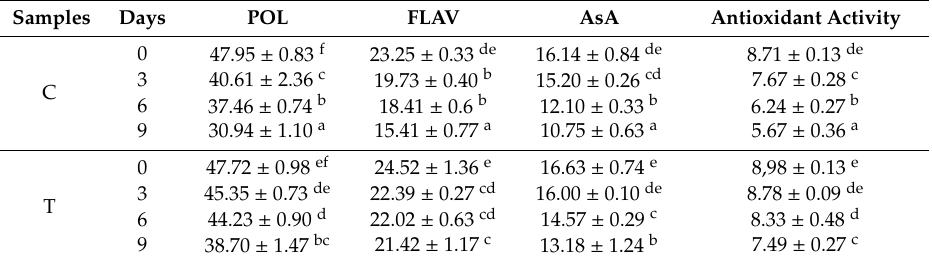
Table 2. Polyphenol (POL; mg GAE / 100 g FW), flavonoid (FLAV; mg CE / 100 g FW), ascorbic acid content (AsA; mg / 100 g FW) and antioxidant activity (DPPH method; µ mol TE / g FW) in coated (chitosan 1% and ascorbic acid 1.5%; T) and uncoated fruits (C) during nine days of cold storage at 4 ◦ C.